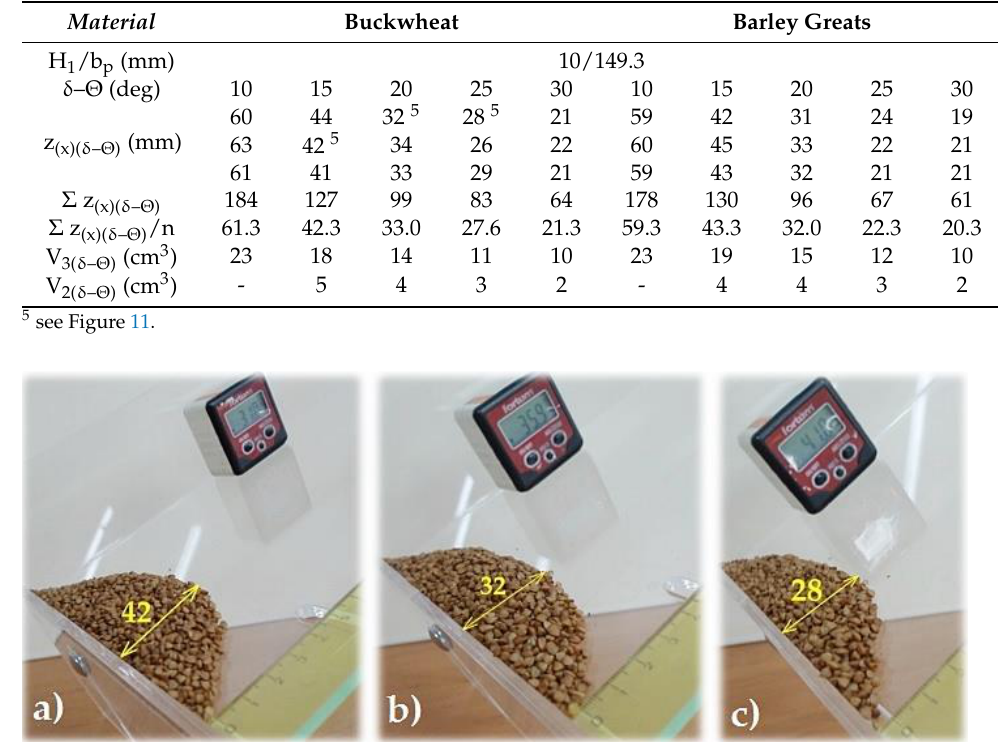
was then increased, always by increments of 5 deg, and the values (for three successive measurements) of the distance of material distribution on the trough surface and the volume of material that spilled over the belt cleat were recorded in Tables 5 and 6, as Table 5. Volume of material V i( δ–Θ ) [cm 3 ] for H 1 = 10 mm belt cleat. determined by subtraction in the measuring cylinder. Table 5. Volume of material V i( δ – Θ ) [cm 3 ] for H 1 = 10 mm belt cleat.